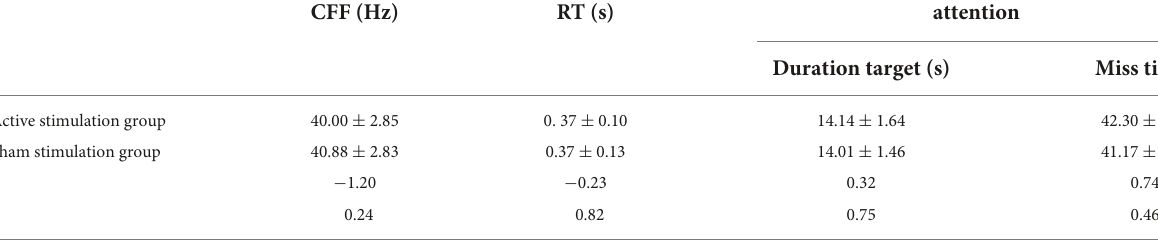
TABLE 3 Analysis of baseline data of behavior test of two groups of subjects.